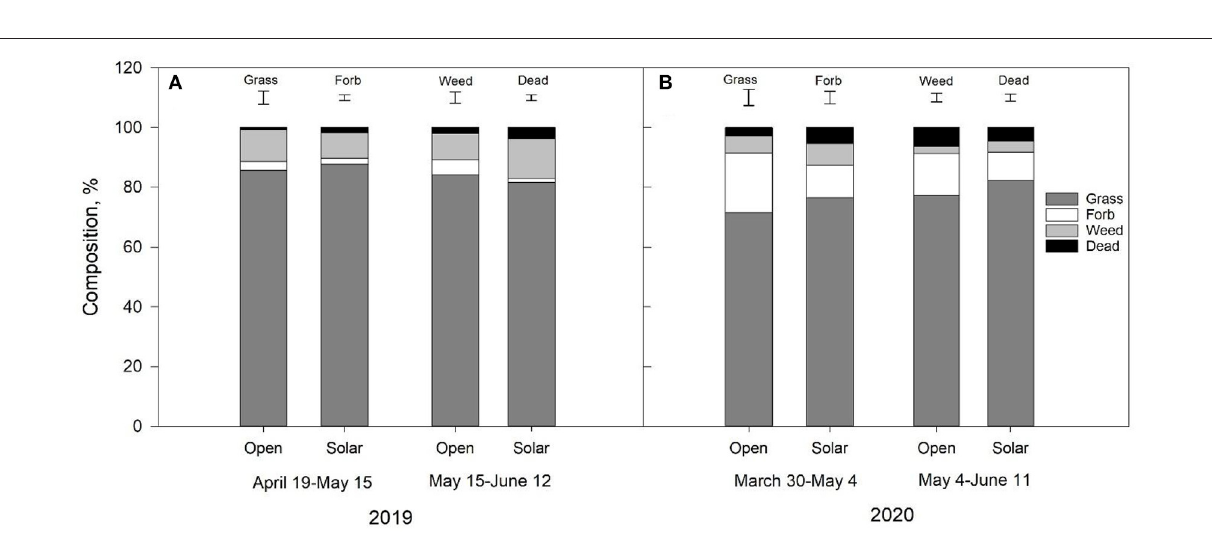
liveweight gains of the lambs dropped to 51 g head − 1 d − 1 ( P